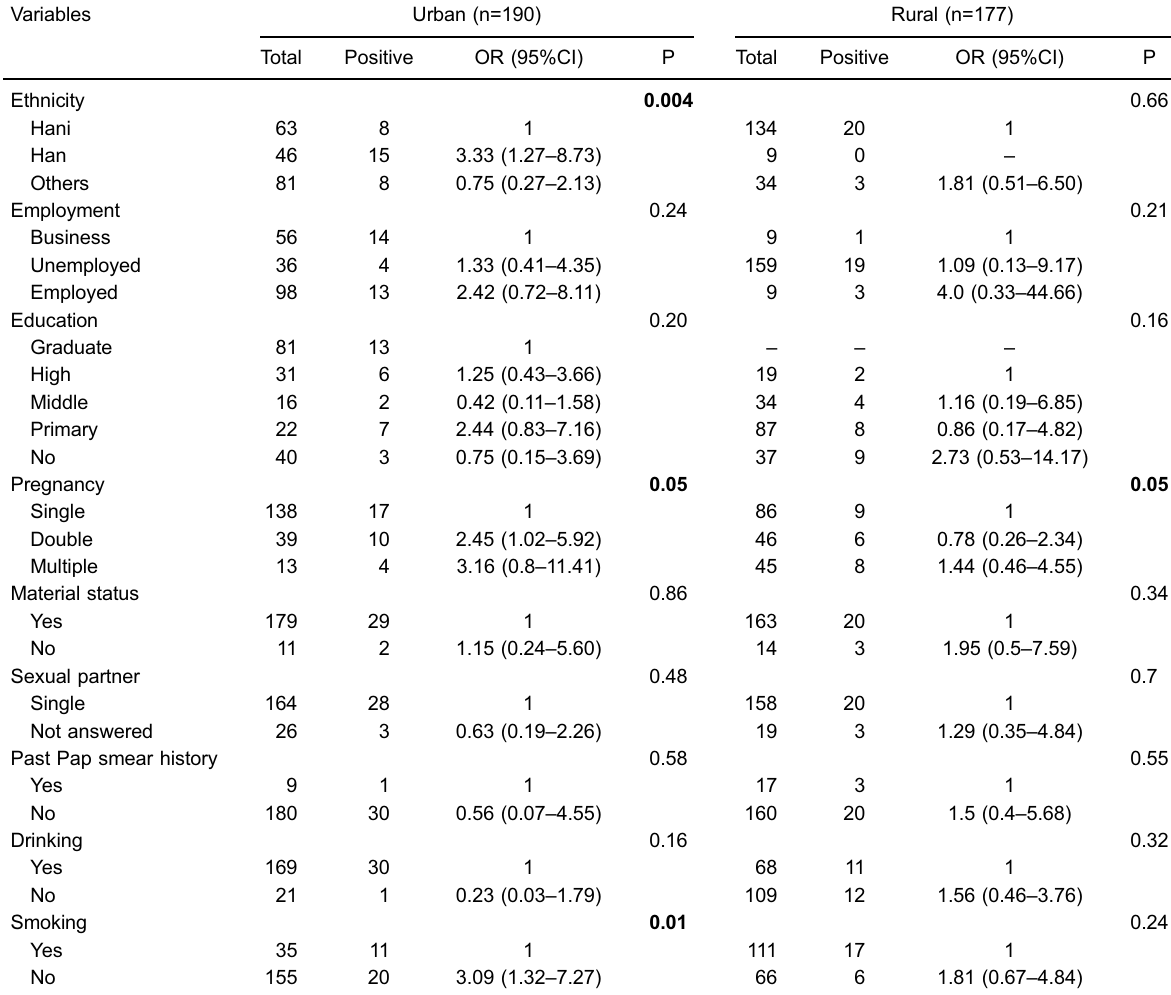
Table 2. Relative risk factors for acquiring HPV infection among samples from rural and urban populations in China.